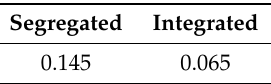
Table 2. Comparison between the χ 2 for the segregated method and the integrated